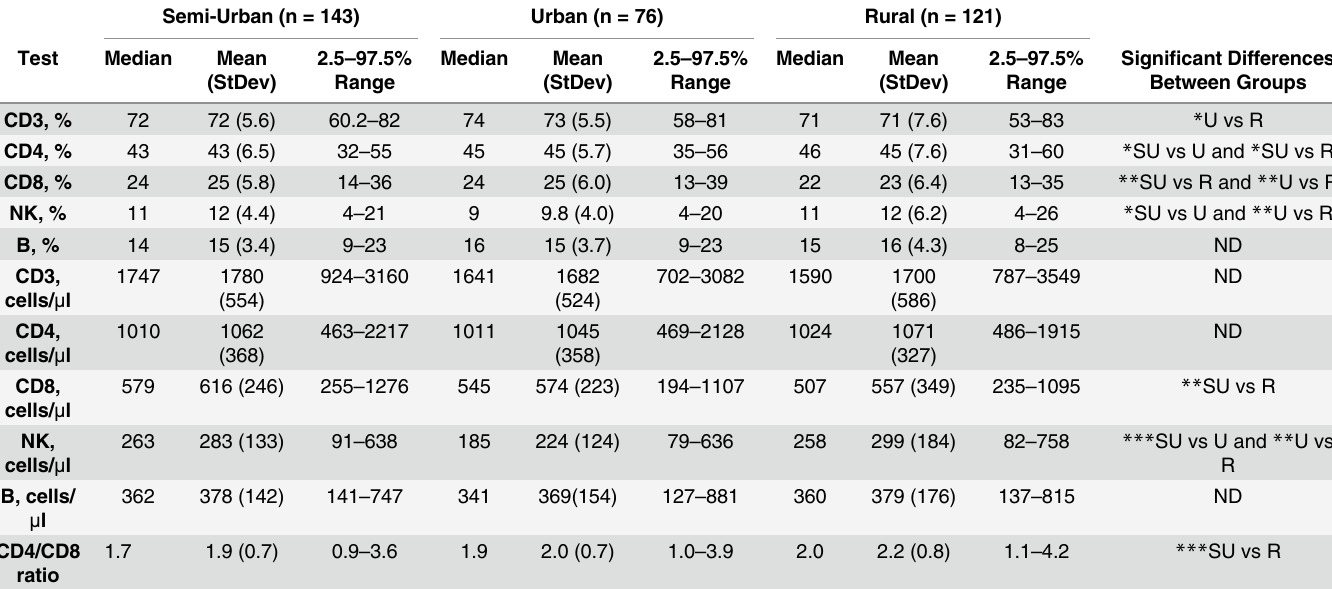
Table 4. Comparison of lymphocyte subset frequency and absolute counts in females. Semi-Urban (n =